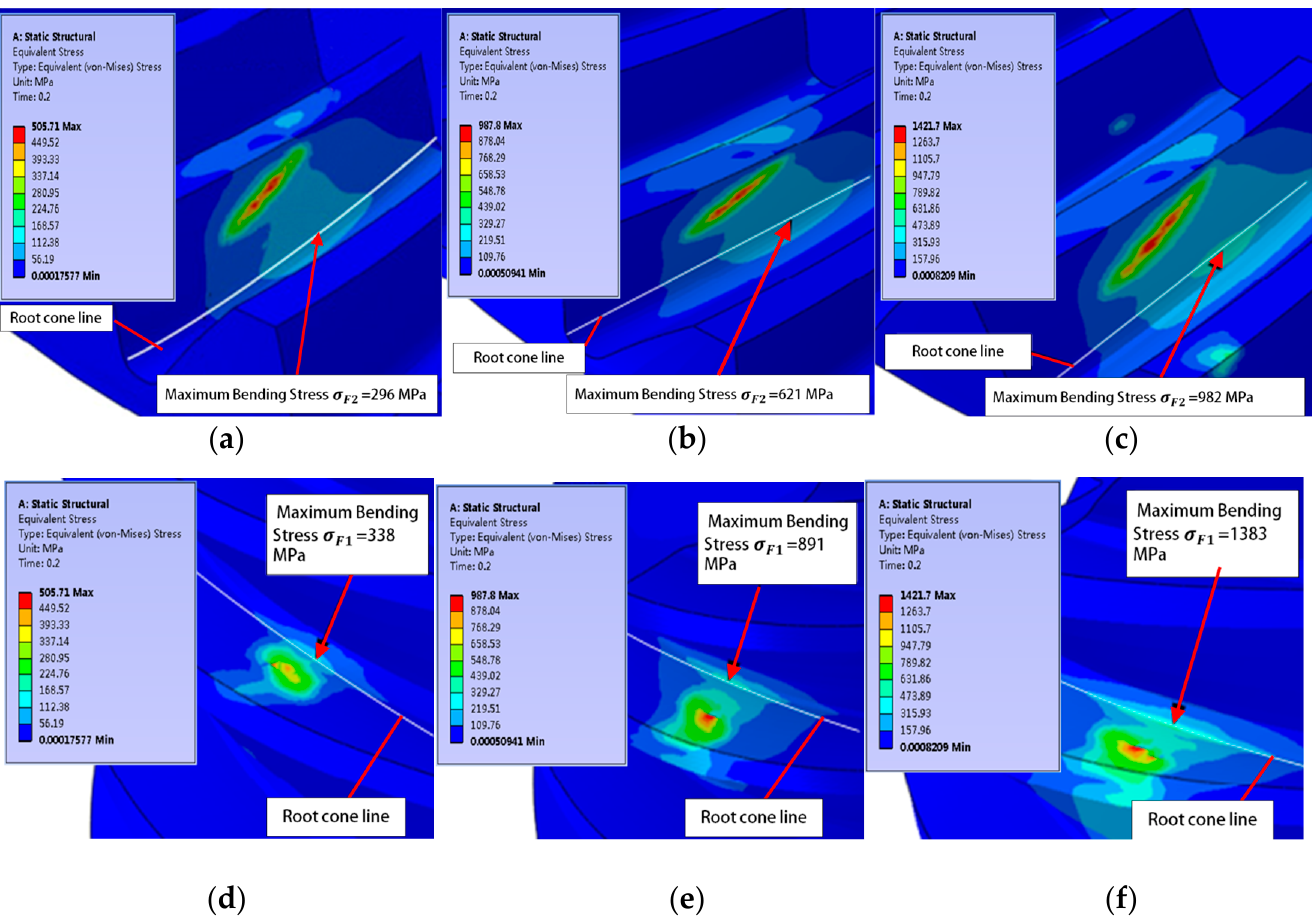
Figure 12. Comparison of maximum root bending stress of the gear and pinion: ( a ) the gear T 2 = 1500 Nm, ( b ) the gear T 2 = 4500 Nm, ( c ) the gear T 2 = 7500 Nm, ( d ) the pinion T 1 = 1500 Nm, ( e ) the pinion T 1 = 4500 Nm, and ( f ) the pinion T 1 = 7500 Nm.